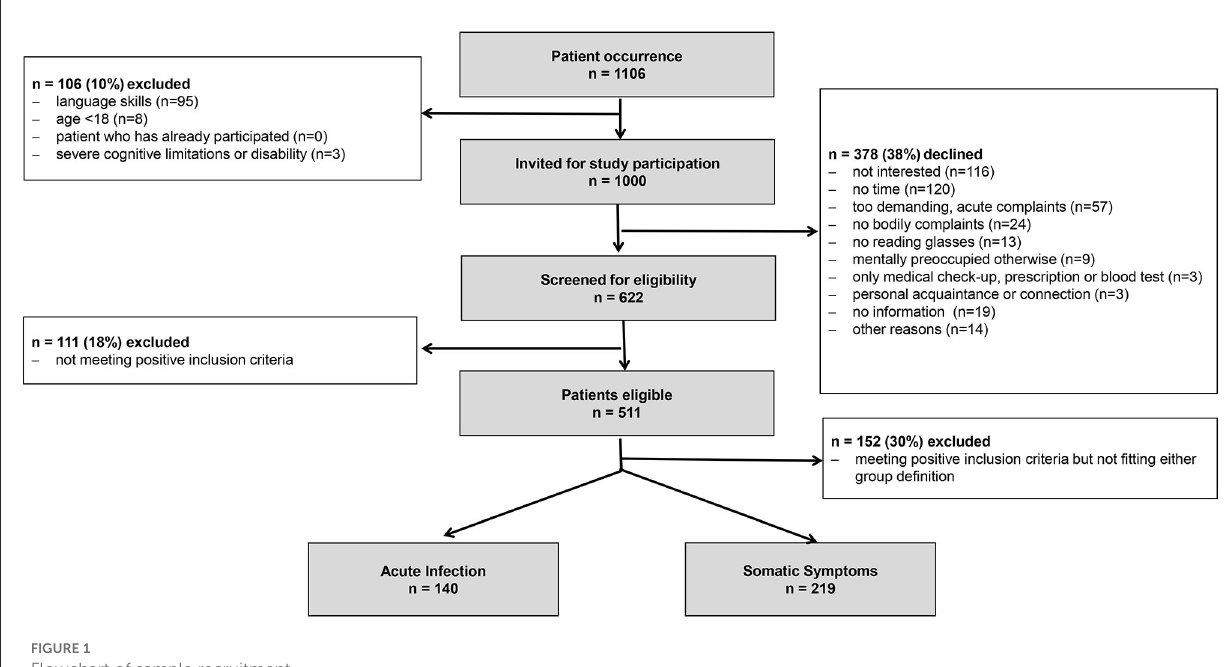
FIGURE1 Flowchart of sample recruitment.